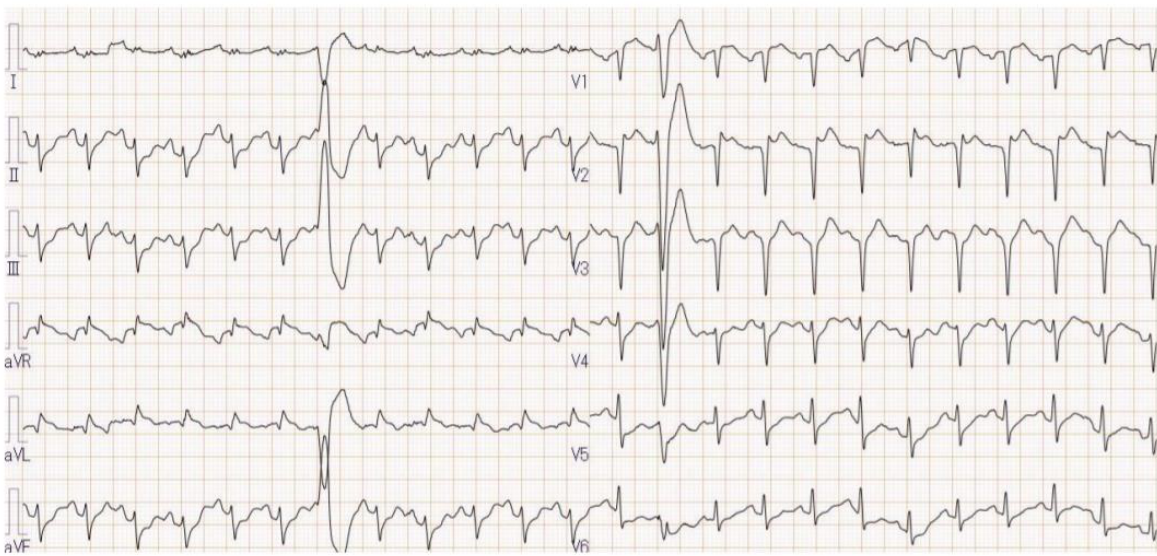
Figure 1. ECG on Figure 1. ECG on admission.